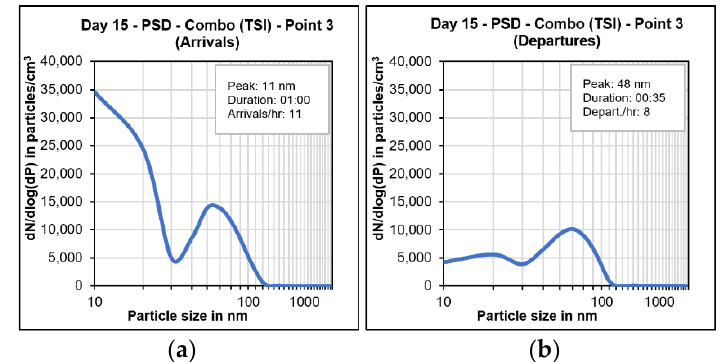
Figure 8. PSDs on day 15 at point 3 of ( a ) arrivals and ( b ) departures.